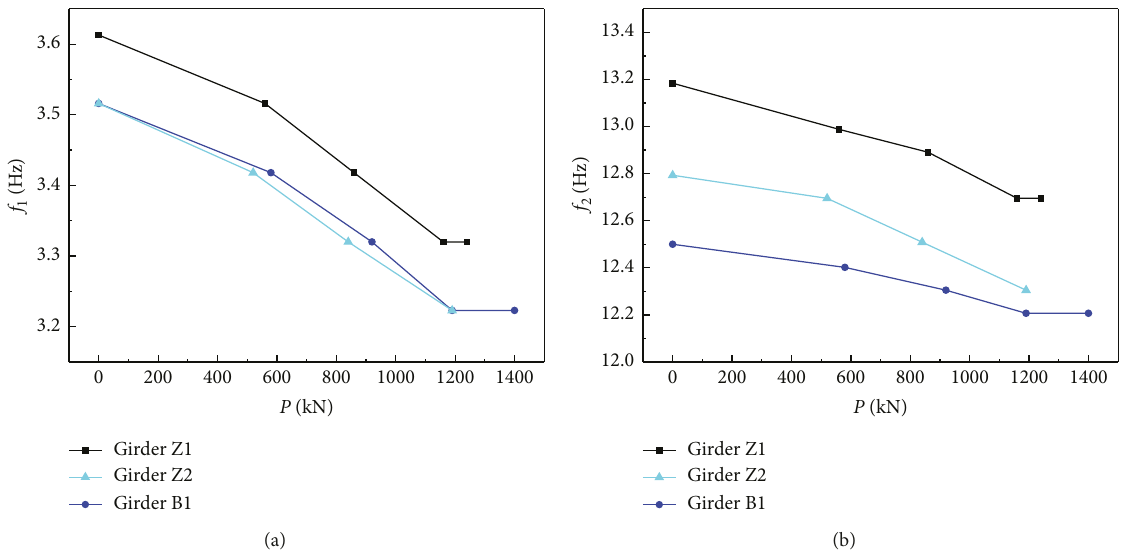
Figure 10: Natural frequencies of the test girders. (a) The first frequency. (b) The second frequency. Table 5: Natural frequencies of the test girders. Girder Damage degree f / f 2